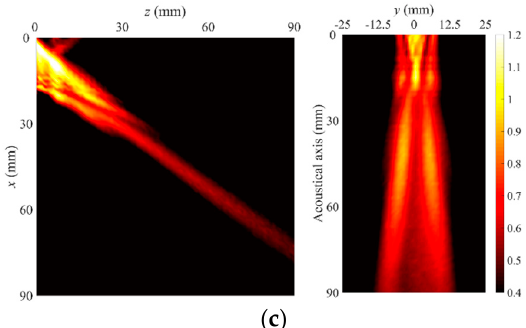
Figure 10. Measured leaky radiation beam profiles radiated from a SS304 plate (1.5 mm thickness, 15 mm width) with variation of the excitation source position, ( a ) d = 300 mm, ( b ) d = 350 mm, and ( c ) d = 400 mm.